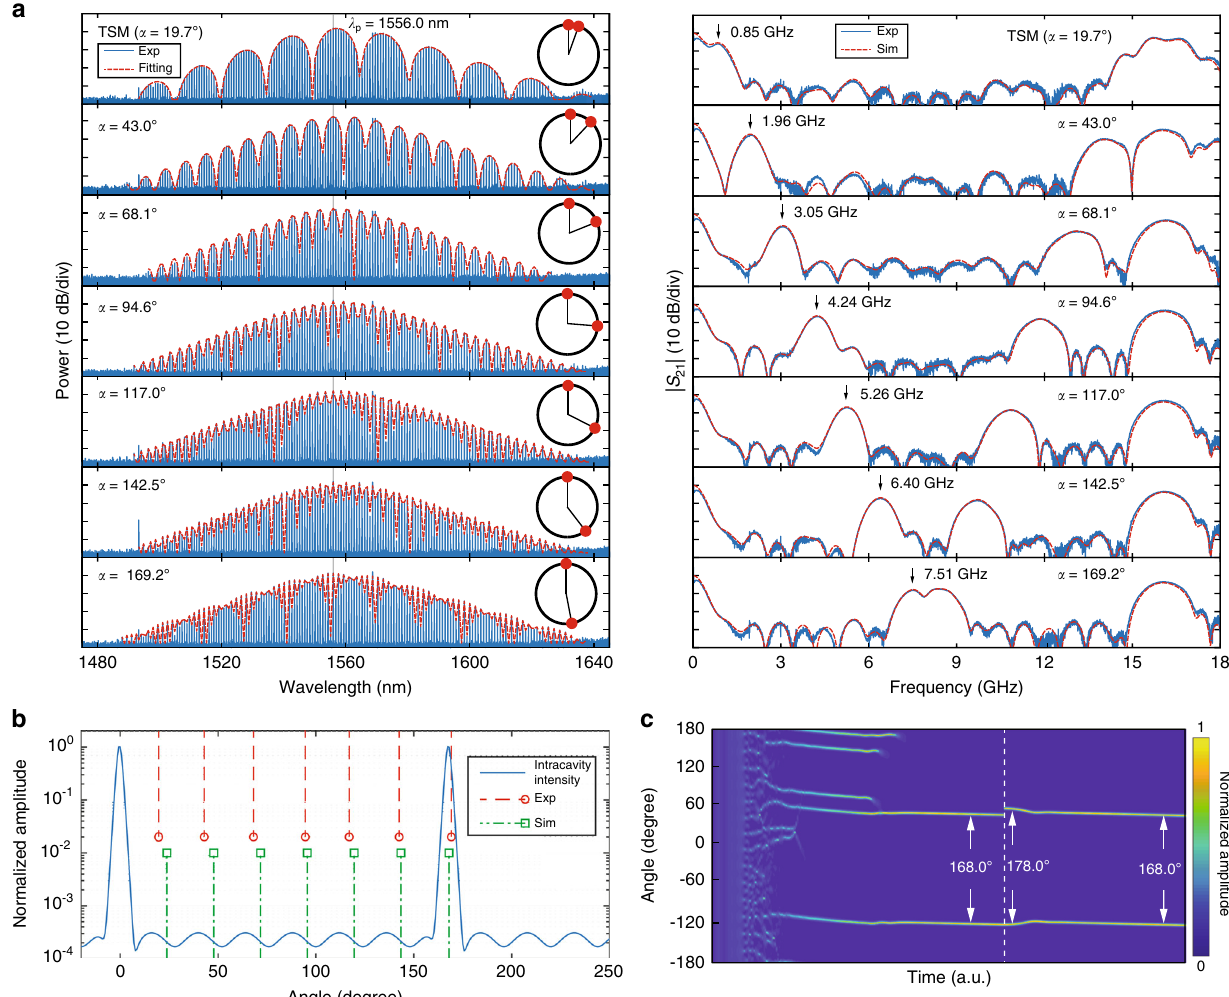
Fig. 3 TSM spectra and their corresponding RF photonic fi lters, together with TSM simulation investigation. By accessing different two-soliton states, the RF fi lters can be all optically recon fi gured. a Left column: TSM spectra at resonance of 1556.0 nm (blue: experiment; red: envelope fi tting). The insets illustrate two-soliton distribution inside the microresonator: the angles between them are 19.7°, 43.0°, 68.1°, 94.6°, 117.0°, 142.5°, and 169.2°, respectively. Right column: corresponding normalized RF fi lter responses (blue: experiment; red: simulation) with passbands at 0.85, 1.96, 3.05, 4.24, 5.26, 6.40, and 7.51 GHz, respectively. b Simulation of TSM relative azimuthal angles. One example of the simulated TSM intracavity intensity pro fi le (blue), where AMX- induced background modulation is observed. The red and green lines, respectively, indicate the measured and simulated possible azimuthal angles between two solitons. c Simulation of the intracavity waveform evolution of TSM for robustness test. First, TSM state with a relative angle of 168.0° is excited by scanning the pump over the resonance. Once the TSM becomes stable, a 10.0° perturbation is introduced to one of the solitons at white dashed line. The relative angle will re-stabilize to the original angle of 168.0° after a period of free